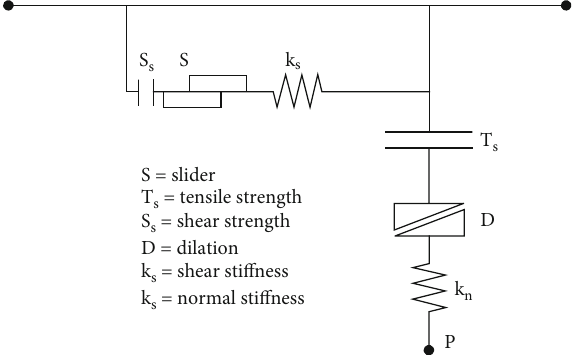
Figure 2: Components of the interface constitutive model. (Note: this fi gure is reproduced from Shuwei Sun et al.